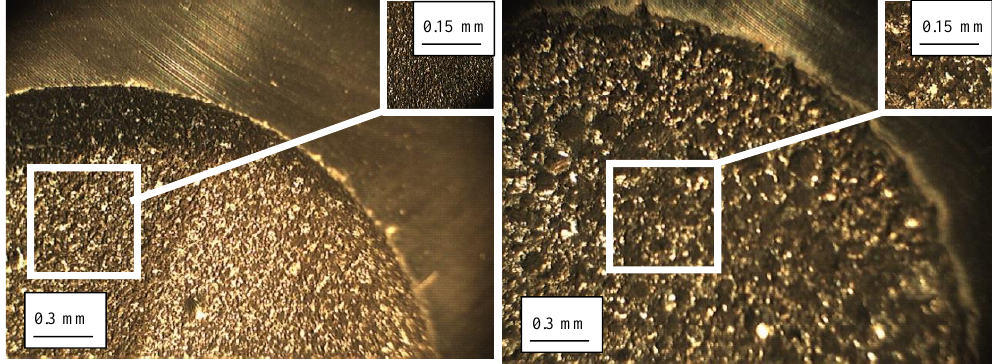
Figure 8. Details of the best ( left ) and worst ( right ) edge and surface finish with the MoCuSi ingot. Due to the erosion and the corrosion (chemical and thermal attack), the electrodes suffer wear.